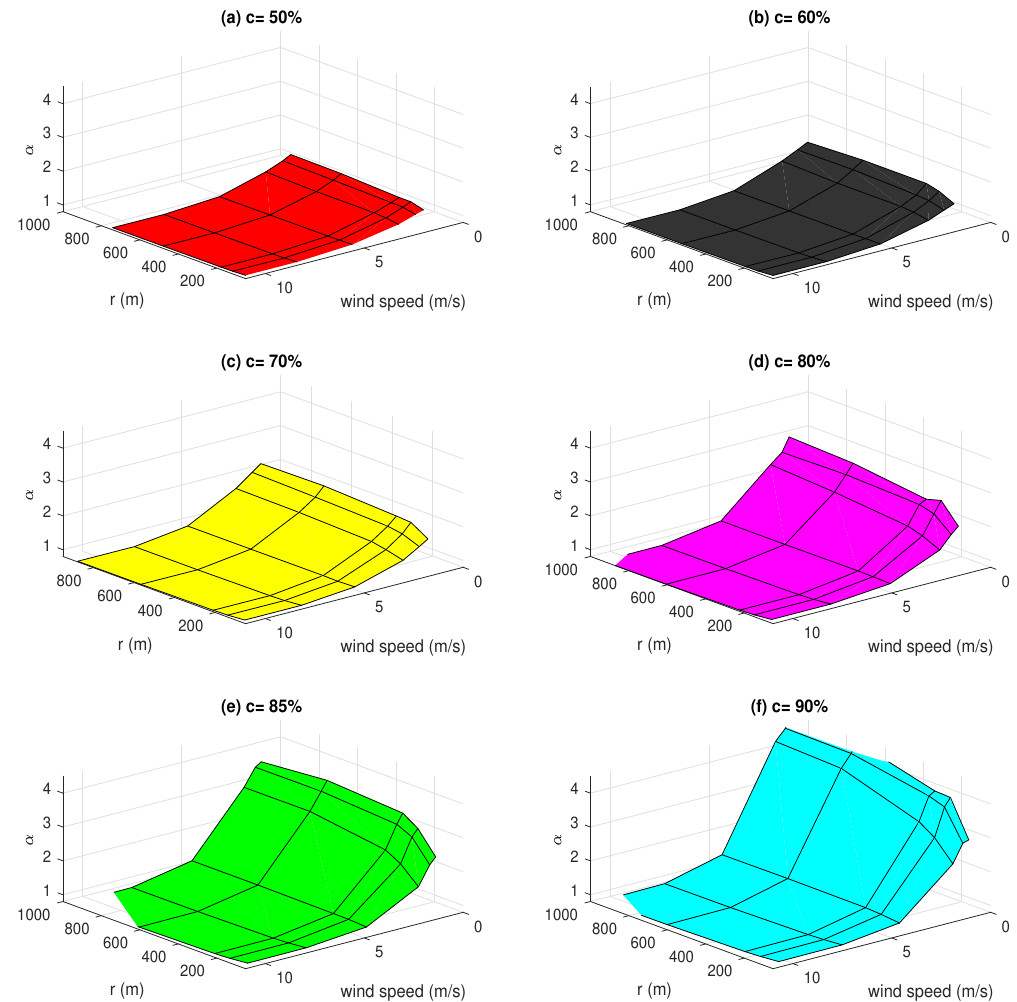
Figure 5. Values of the α coefficient for every WRF model simulation with different ambient wind speed U m and median floe size r , plotted for all sea ice concentrations considered in the analysis ( a – f